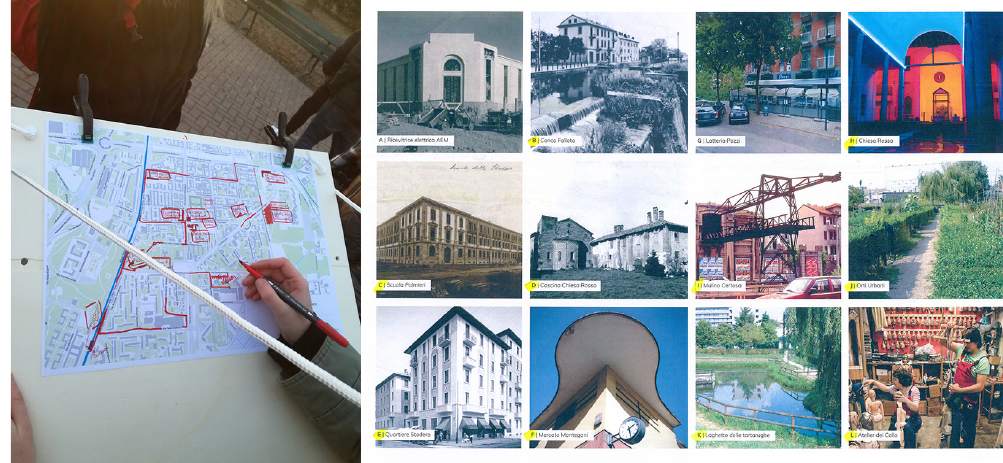
Fig. 5 The route drawn during the learning